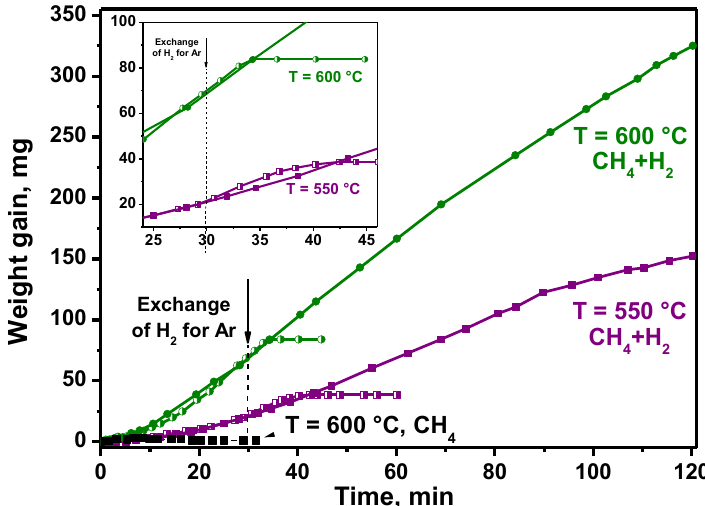
Figure 4. Effect of the presence of hydrogen in the reaction mixture ( m cat = 10 mg, G CH4 = 24 L/h, G H2 = 0 or 3.6 L/h). The inset shows an enlarged area of the main plot.